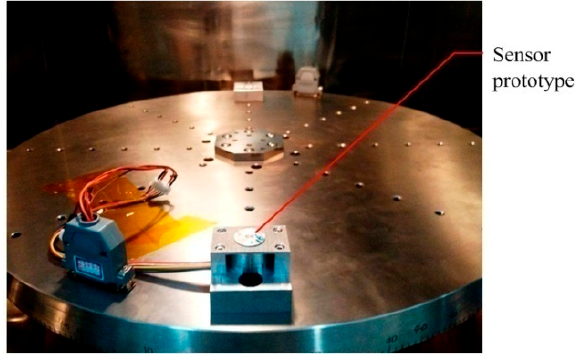
Figure 9. The static calibration device for sensor prototypes.